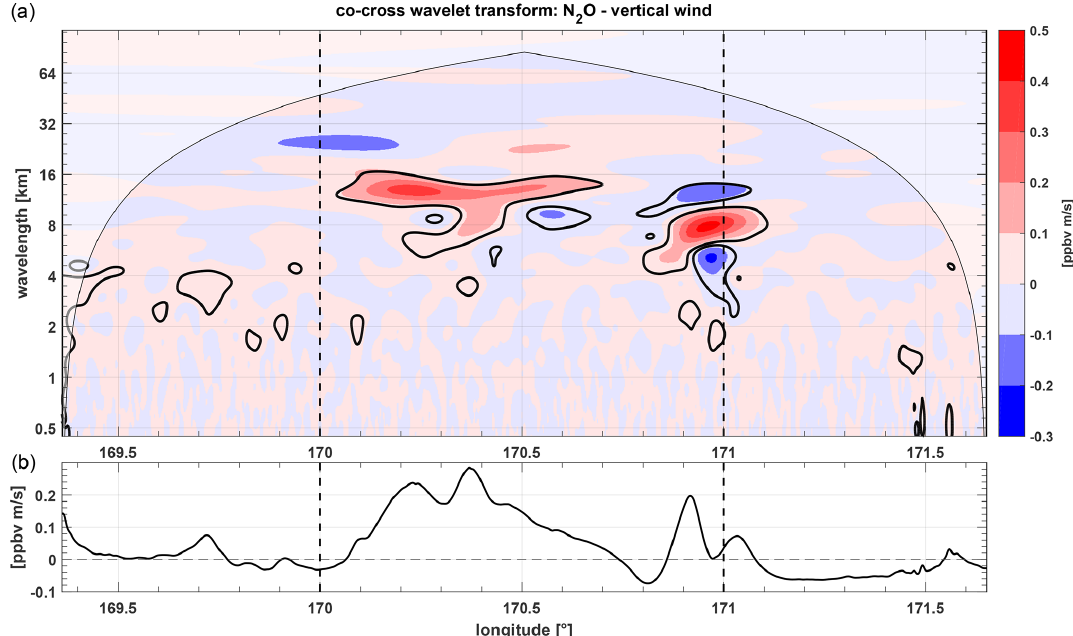
Figure 12. (a) Co-spectrum of the cross-wavelet transformation of N 2 O and vertical wind. The shaded region marks the cone of influence in which edge effects play a role. The black contour lines indicate 5% significance levels against red noise. Red colors denote a positive flux and blue colors indicate a negative flux. (b) Scale-averaged wavelet co-spectrum over all